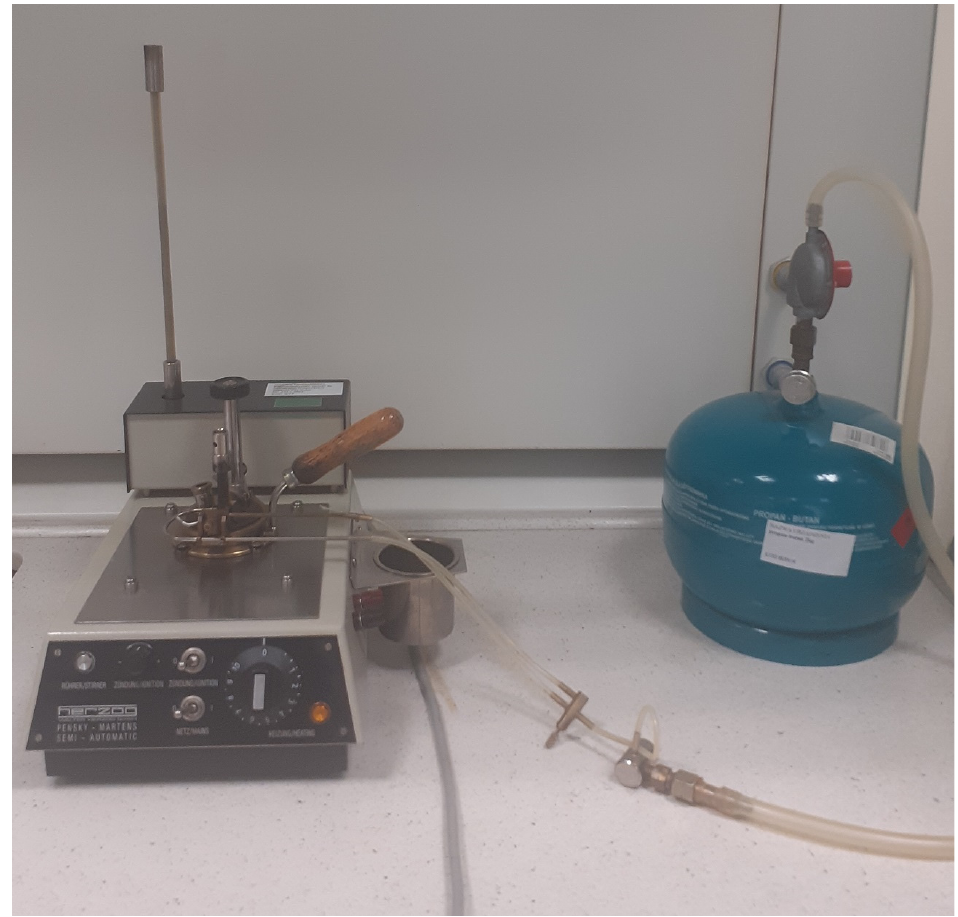
Figure 10. Flashpoint Pensky–Martens semi-automatic apparatus from Walter Herzog GmbH used in the study (photo. M. Szmuka ł a).